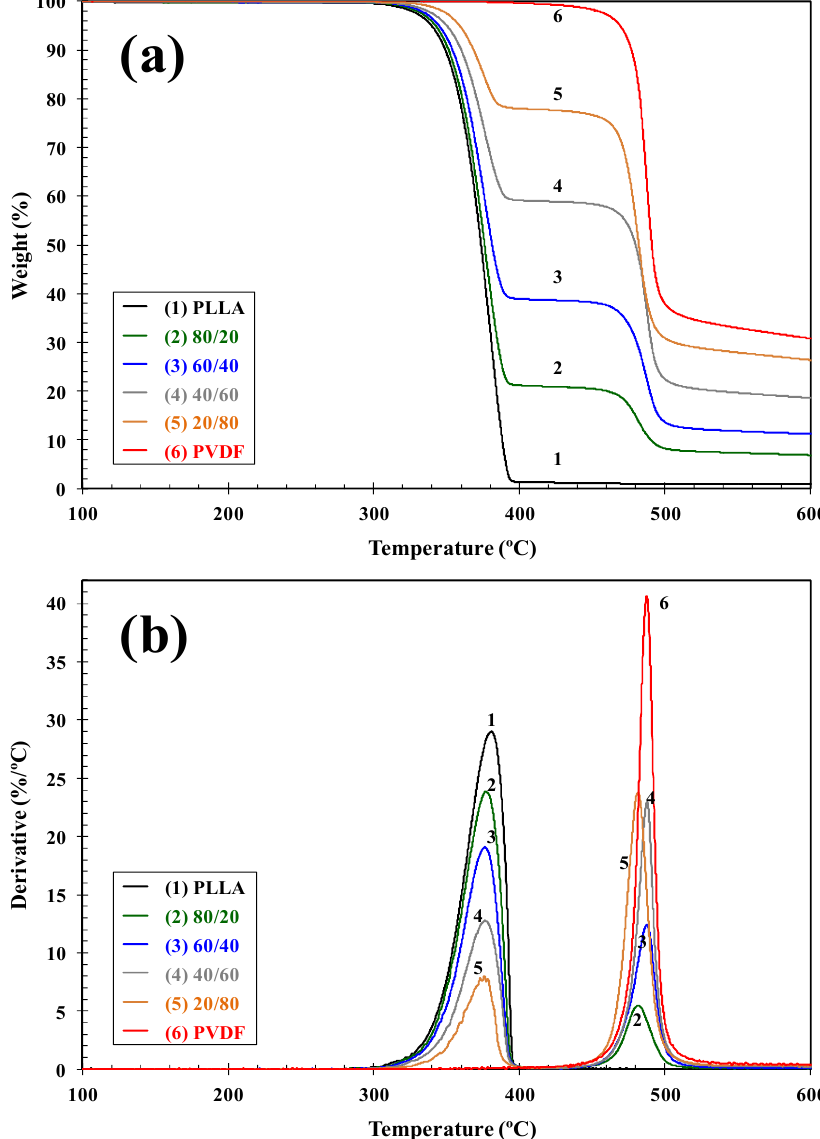
Figure 3. ( a ) Thermogravimetric (TGA) and ( b ) derivative thermogravimetric (DTG) curves of PLLA/PVDF blends.